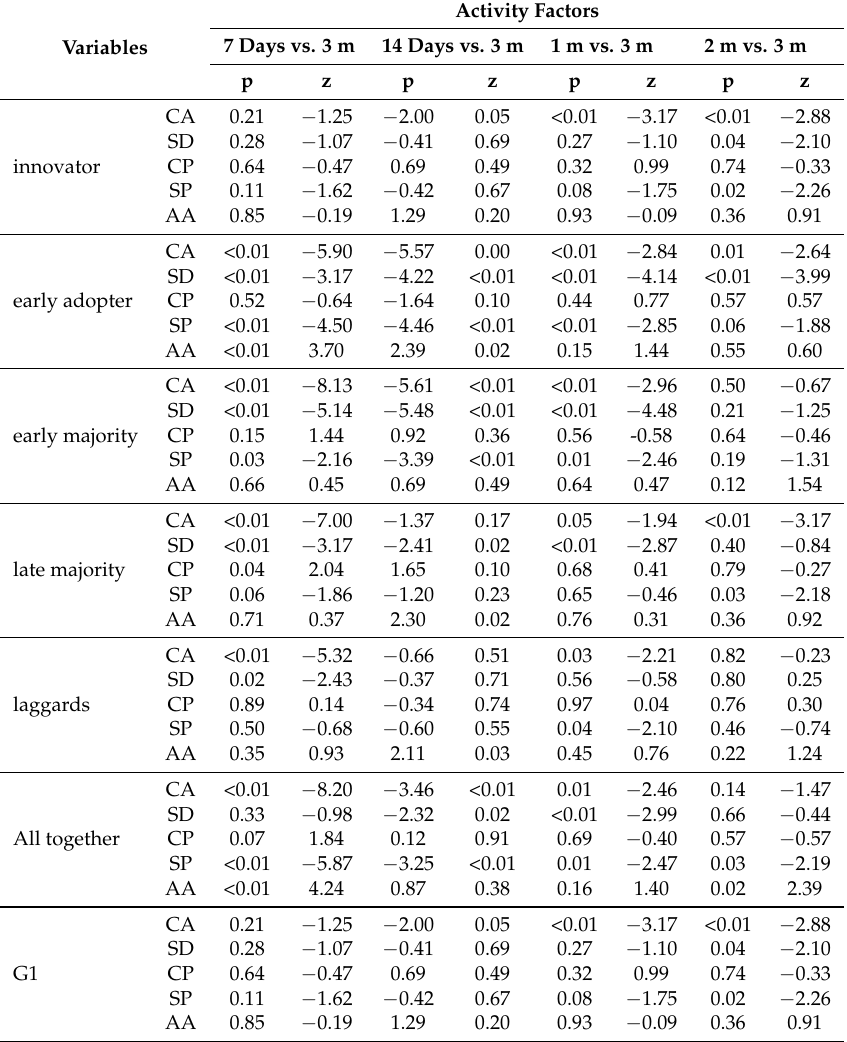
Table A1. Intergroup comparisons using the life expectancy of a product as a dependent variable and as divisional predictors divided into two